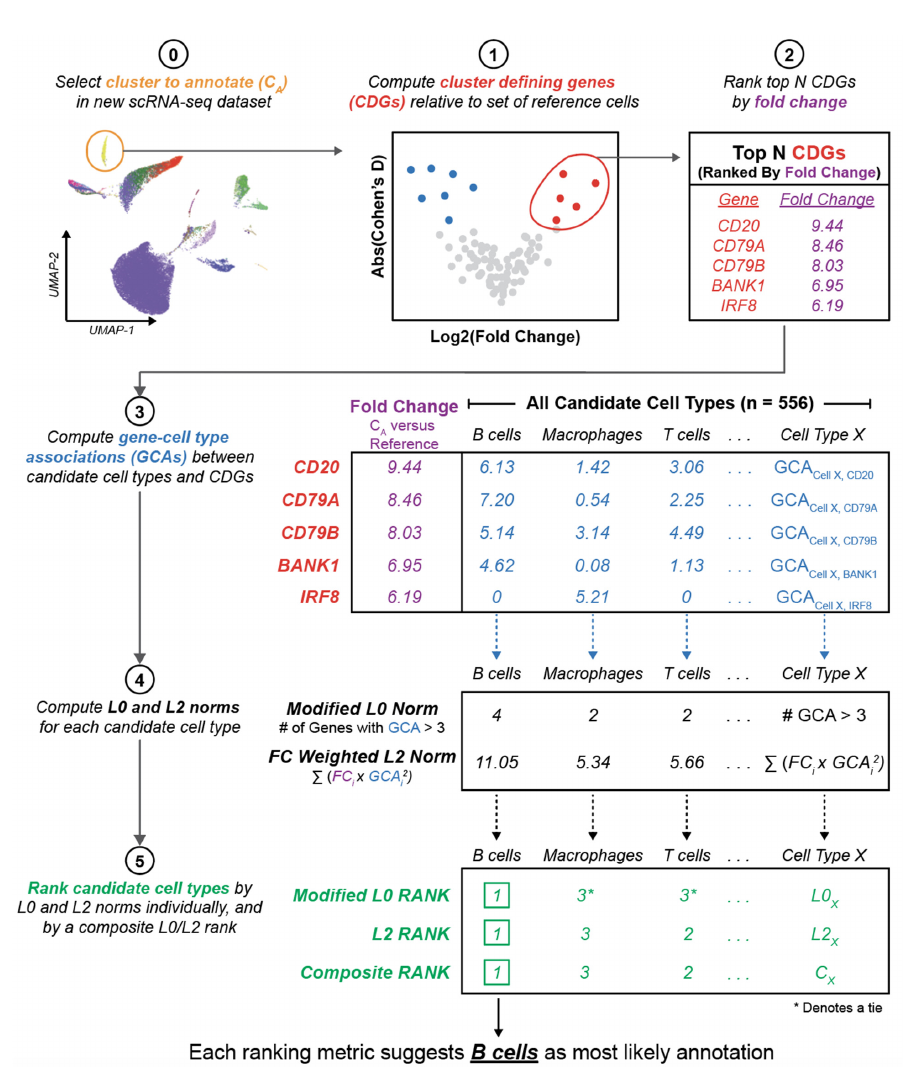
Figure 2. Schematic summary of the approach to leverage the literature knowledge graph to augment the annotation of cell type clusters in scRNA-seq datasets. This illustration presents the example of predicting the annotation of one cluster (B cells) from a previously published scRNA-seq dataset of the human kidney [40]. After clustering a new scRNA-seq dataset (step 0), we compute the top N cluster defining genes for a given cluster C A relative to a defined set of reference cells (steps 1–2). The GCAs between each of these top N genes and all candidate cell types are computed (step 3), and the L0 and L2 norms are computed to summarize the level of literature evidence connecting these CDGs to each cell type (step 4). Candidate cell types are ranked by these norms (step 5), and the cell type showing the strongest association to the set of CDGs is selected as the most likely annotation for cluster C A . Note that only three candidate cell types are shown here for simplicity, but there were actually over 500 cell types considered (which mapped to 104 cell type priority nodes).